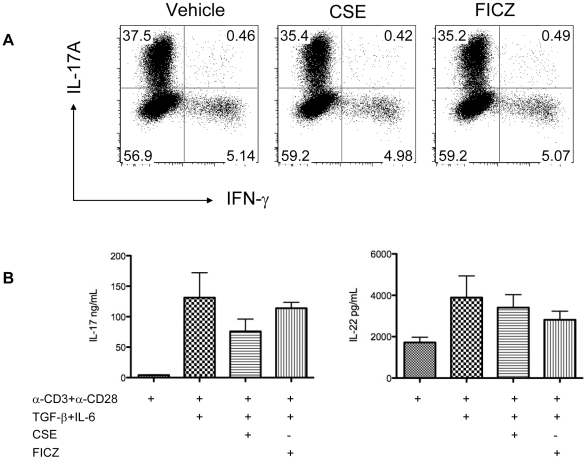
Requirement of AhR for enhanced in vitro Th17 polarization by cigarette smoke extract.Naïve CD4+ T cells from Ahr−/− spleen were activated by plated bounded anti-CD3 and anti-CD28 in the presence of TGF-b, IL-6, anti-IFN-γ and anti-IL4. Where indicated, 0.5% CSE or 200 nM FICZ were added into the culture. On day 3, cells were harvested and intracellular cytokines were analyzed by FACS (A). Tissue culture supernatants were harvested from in vitro polarized Th17 cells from Ahr−/− spleen for secreted IL-17 by Luminex and IL-22 by ELISA (B, n = 5 per group, * denotes p<0.05 compared to vehicle-HBSS).